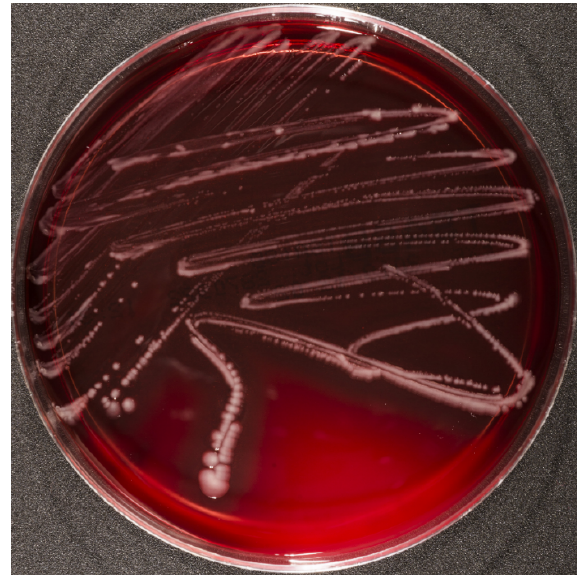
Figure 1: PhotobacteriumdampselaeDSM 110634 growing on Columbia blood agar containing 5% sheep blood (Oxoid, Wesel, Germany). The bacteria were incubated for 18